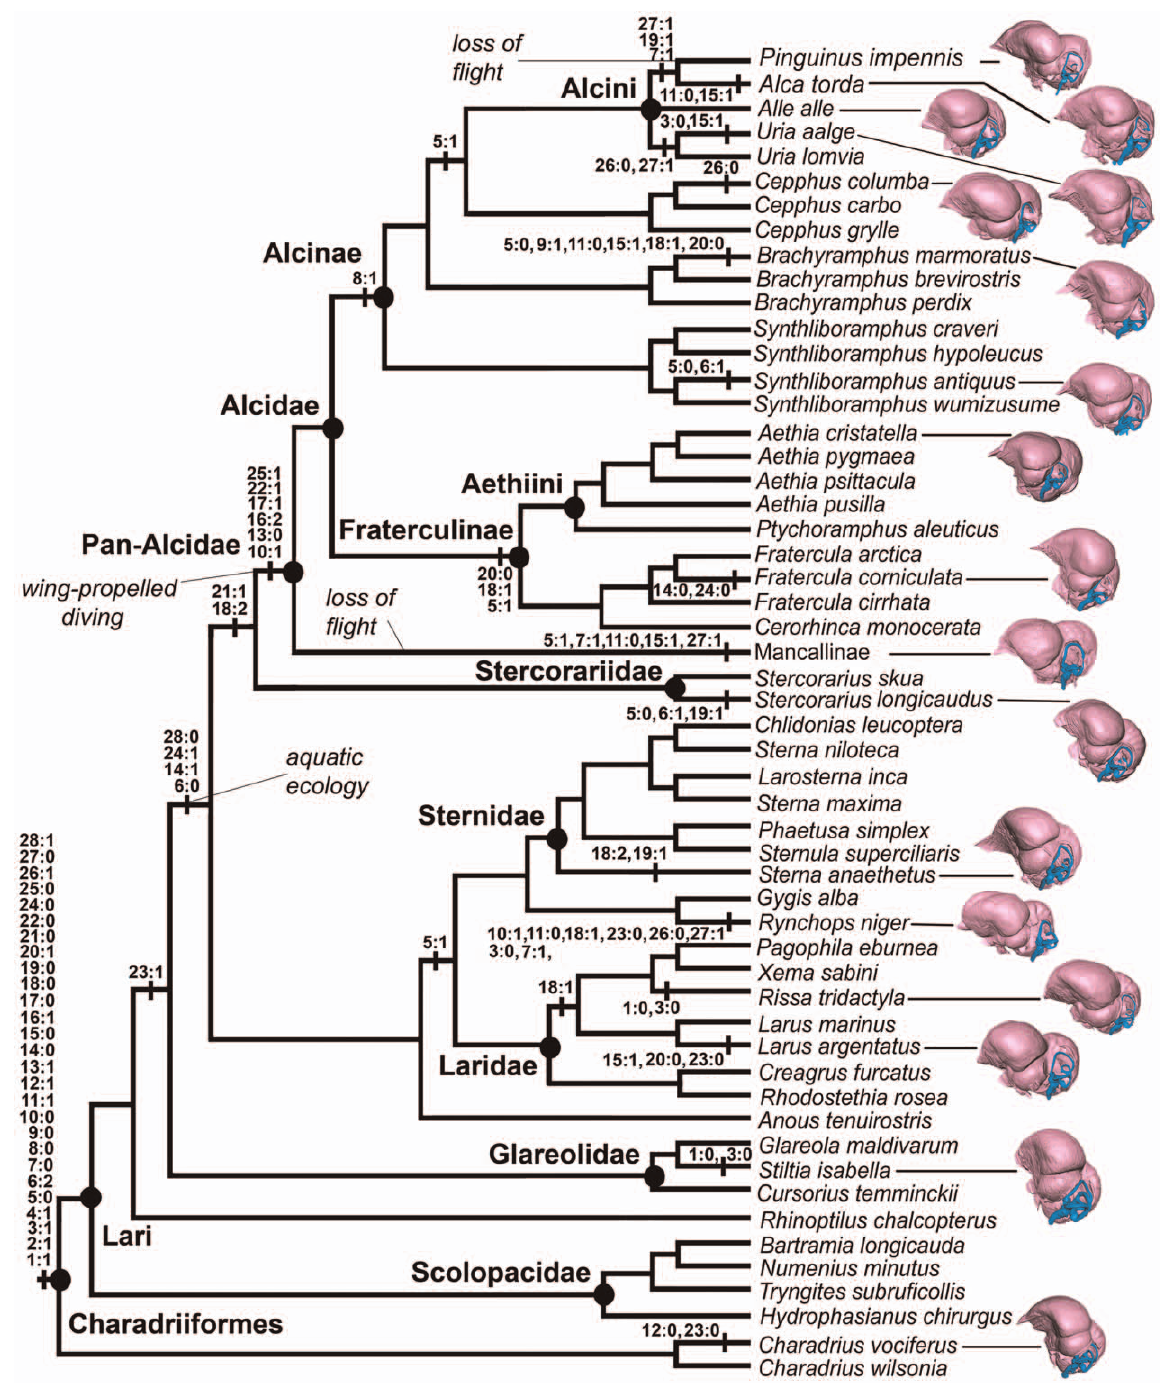
Figure 5. Cladogram of charadriiform relationships showing taxonomic sampling, and all character state changes mapped onto the topology presented by Smith (2011a). Halcyornis toliapicus , New Caledonian Crow Corvus moneduloides , and Great Horned Owl Bubo virginianus are not represented here because they were not included in that analysis (ibid).